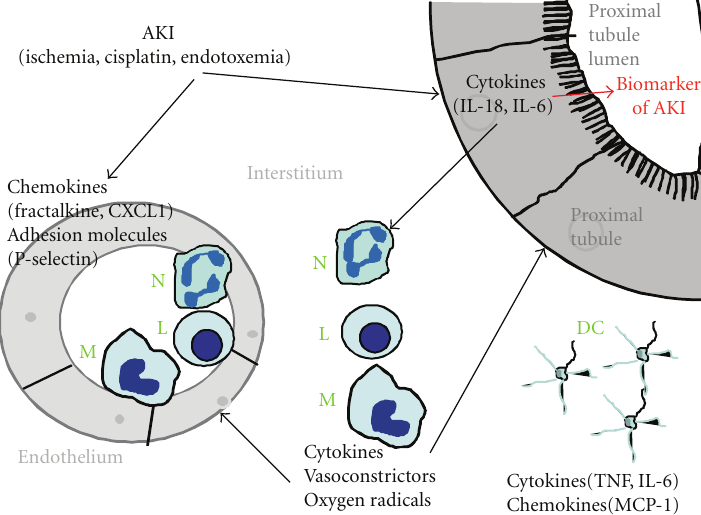
Figure 1: Inflammatory pathogenesis of AKI . AKI results in the upregulation of chemokines like fractalkine and CXCL1 and adhesion molecules like P-selectin in the endothelium of blood vessels in the kidney. Upregulation of chemokines and adhesion molecules in the endothelium results in the infiltration of inflammatory cells like neutrophils (N), lymphocytes (L), and macrophages (M) from the blood vessels into the interstitium of the kidney. Proximal tubular epithelial cells produce cytokines like IL-18 and IL-6. IL-18 and IL- 6 produced by the proximal tubule enter the interstitium and result in activation and/or proliferation of neutrophils (N), lymphocytes (L), and macrophages (M). IL-18 and IL-6 are also released from the proximal tubular cells into the tubular lumen where they serve as early urinary diagnostic biomarkers of AKI. Inflammatory cells produce vasoconstrictors (prostaglandins, leukotrienes, and thromboxanes) that may a ff ect vascular injury and oxygen radicals that may worsen tubular and vascular injury. Resident dendritic cells (DCs) form a contiguous network throughout the entire kidney. The role of DCs in AKI is not well understood. Following kidney ischemia-perfusion, resident dentritic cells release cytokines like TNF and IL-6 and chemokines like MCP-1.